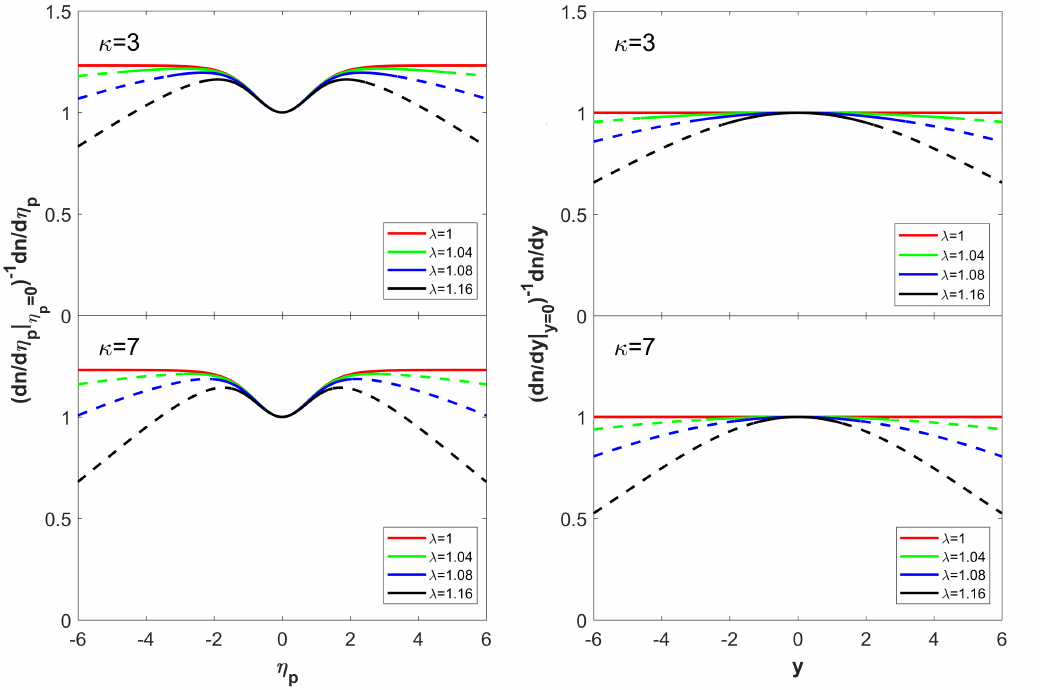
Figure 5. Left panel indicates the pseudorapidity η p densities while the right panel the rapidity y densities, as obtained from our new class of exact solutions of relativistic hydrodynamics, for κ = 3 (top panels) and for κ = 7 (bottom panels), evaluated for the acceleration parameters λ = 1.0, 1.04, 1.08 and 1.16 (curves from top to bottom) corresponding to a rapidity distribution that is flat in the boost-invariant limit, and that becomes gradually narrowing with increasing acceleration parameter λ